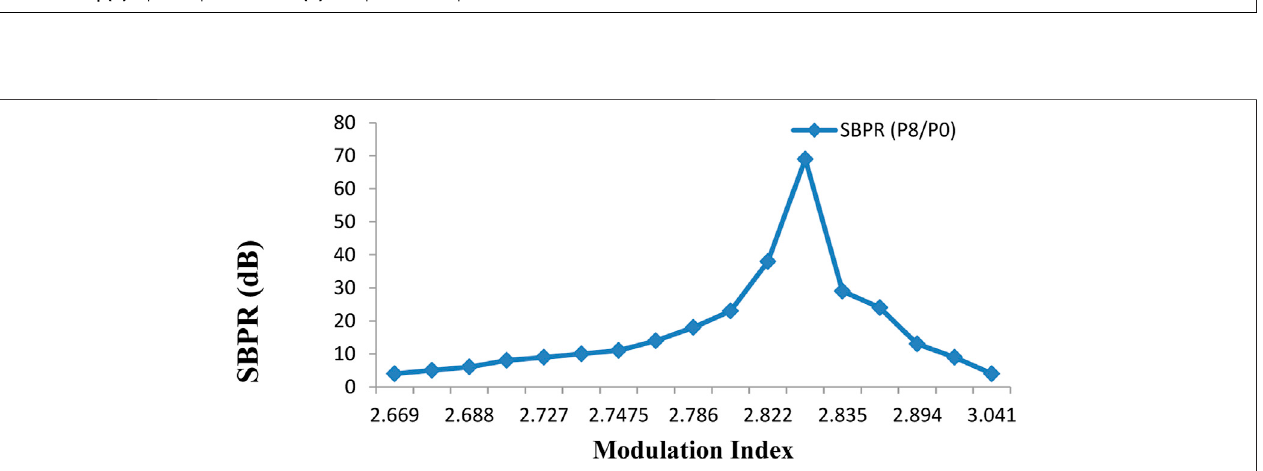
Frontiers in Physics |